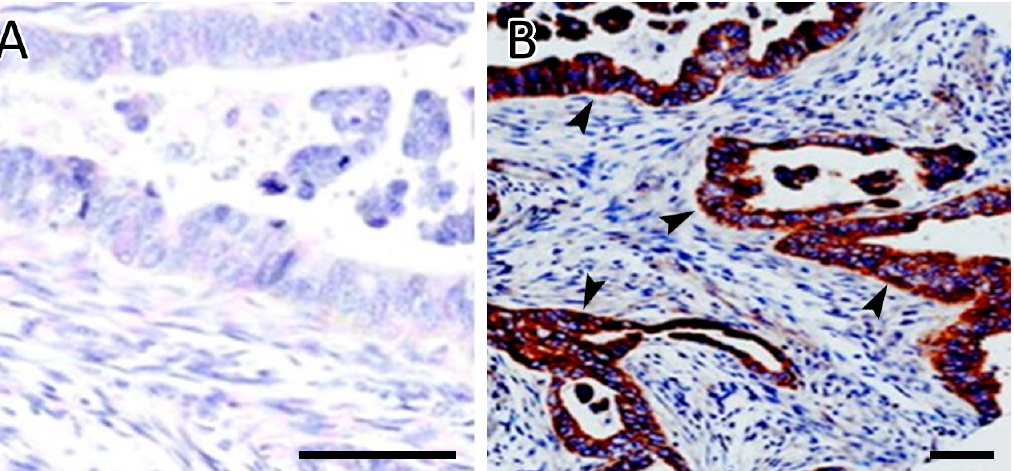
Figure 3. Immunohistochemical analysis of SRC expression. ( A ) Negative staining of tumor cells for Src. ( B ) Strong and diffuse cytoplasmic staining of tumor cells for Src. Arrowheads indicate representative SRC cytoplasmic staining. Scale bars = 50 μ m.